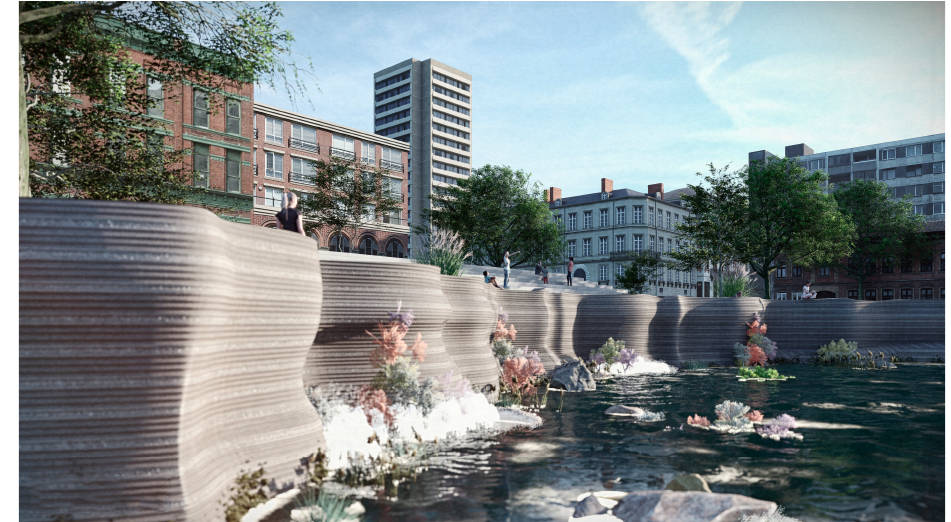
Figure 2. Rendering showing the adaptive urban coastline protection structure.